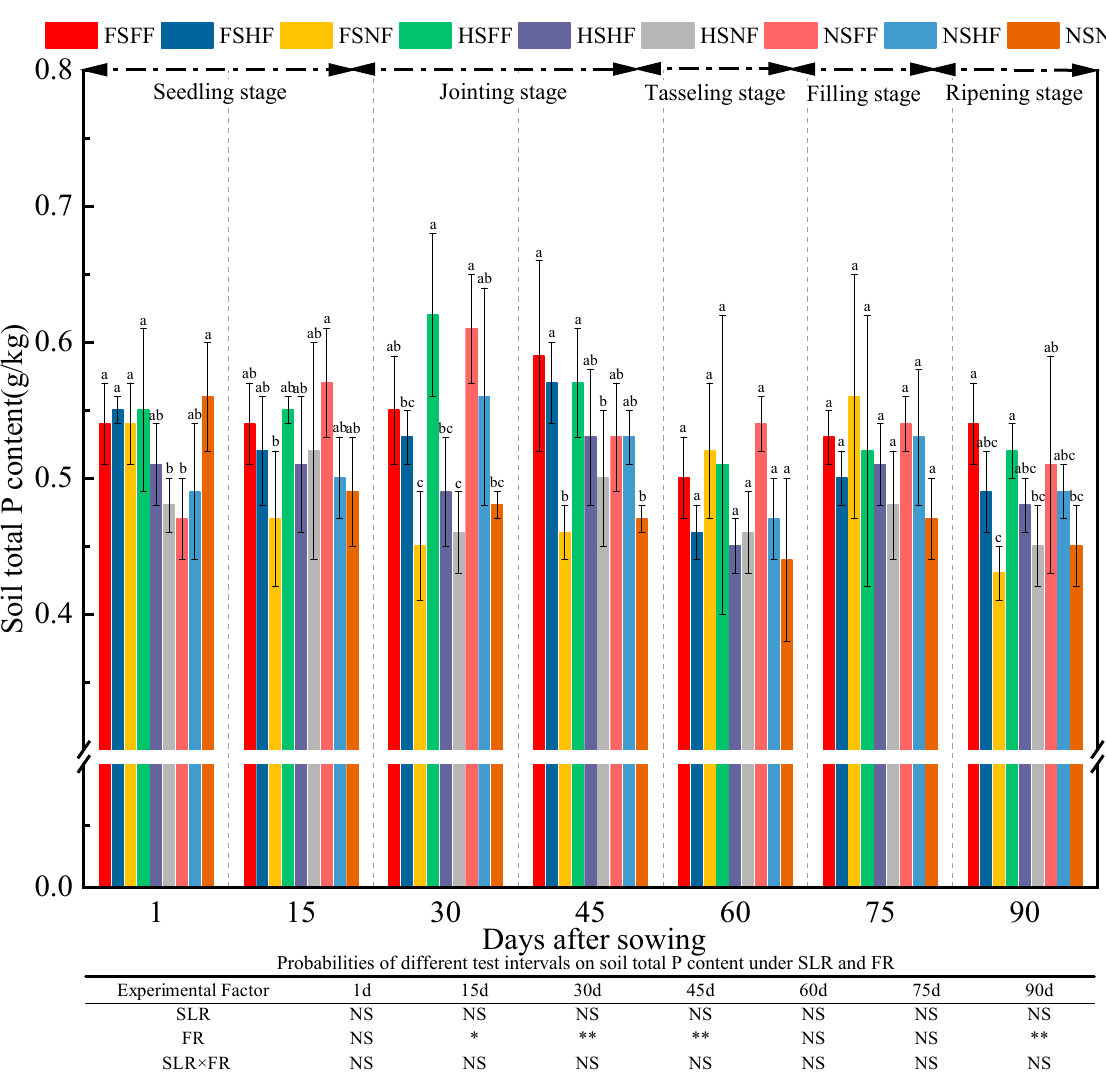
Figure 8. Effects of SLR and FR on soil TP content. Note: Bars represent means ± standard deviation ( n = 3) with different letters indicating significant differences based on LSD ( p ≤ 0.05). SLR, sugarcane leaf return; FR, fertilizer reduction.